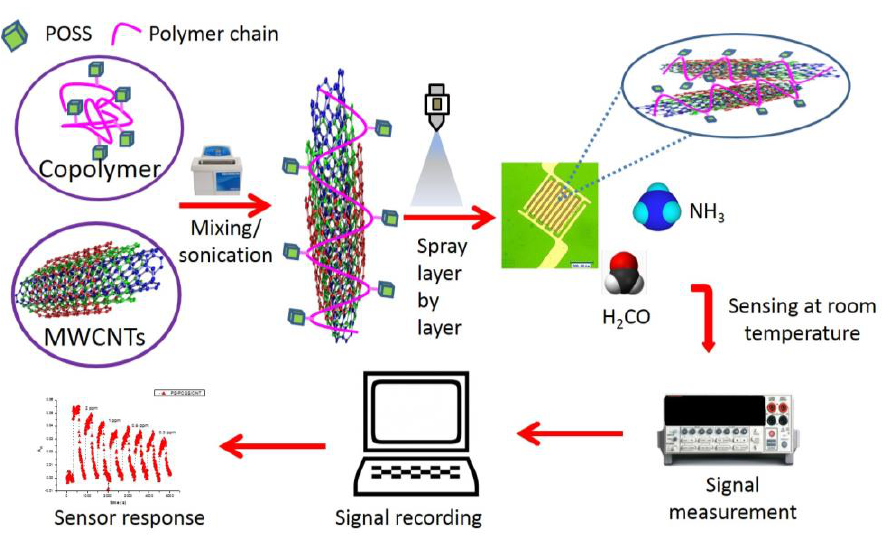
Figure 2. Scheme of the development, assembly, fabrication, and chemo-resistive characterization of quantum resistive vapour sensors (vQRS).